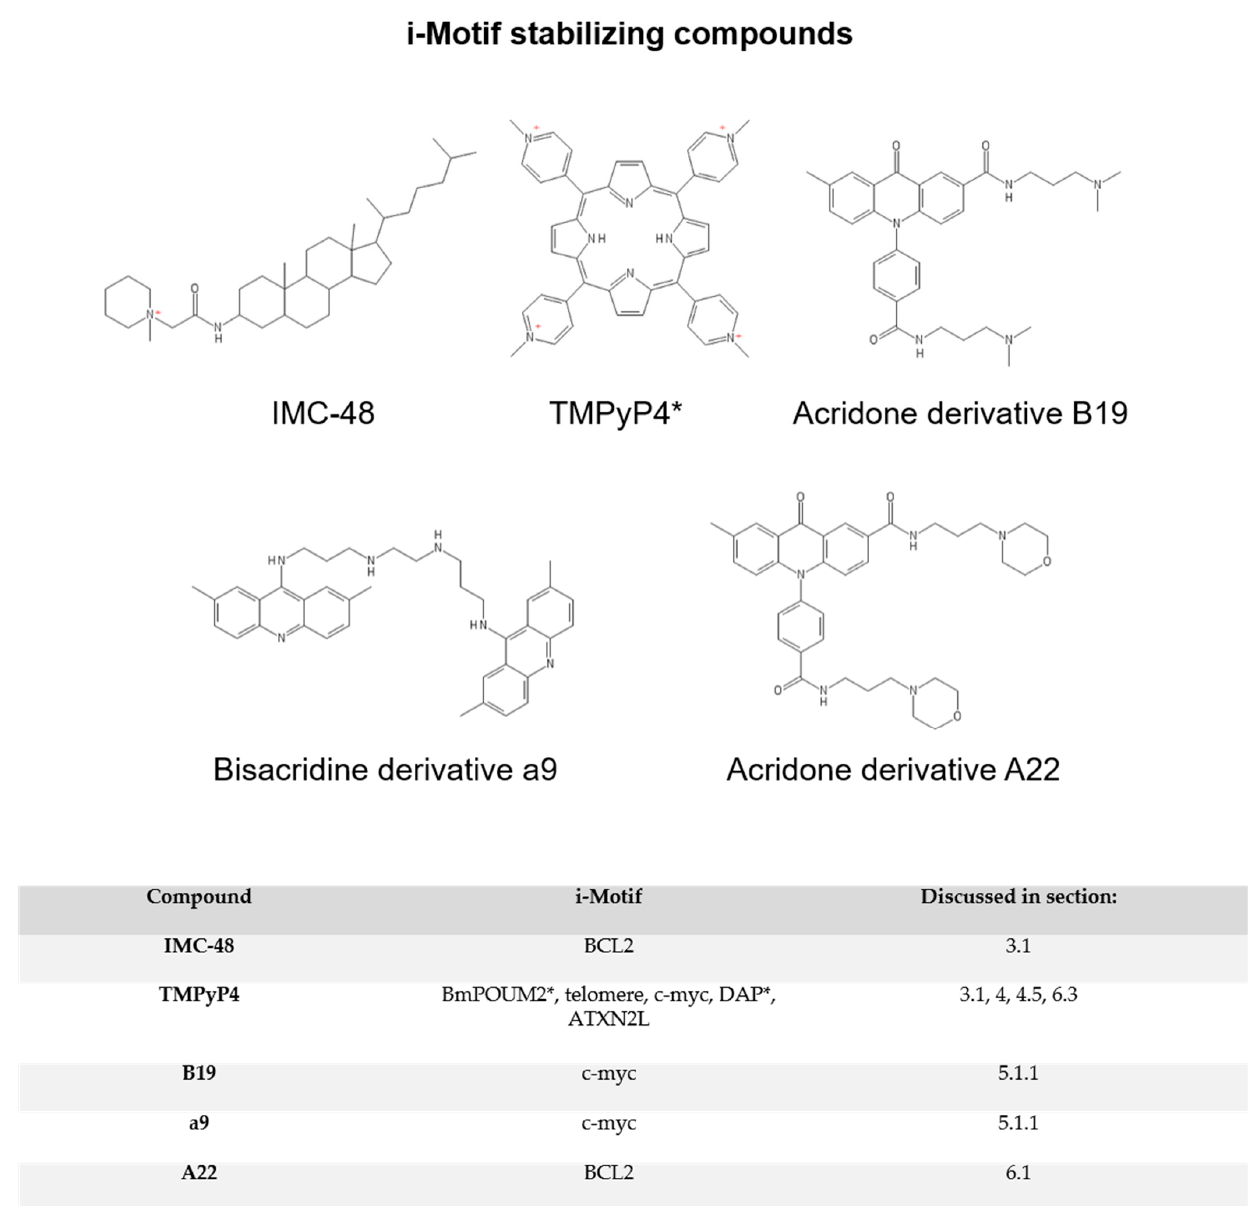
Figure 3. i-Motif stabilizing compounds. * TMPyP4 can also be a destabilizer, depending on the i-motif in question. In the table below, asterisks denote i-motifs destabilized by TMPyP4.